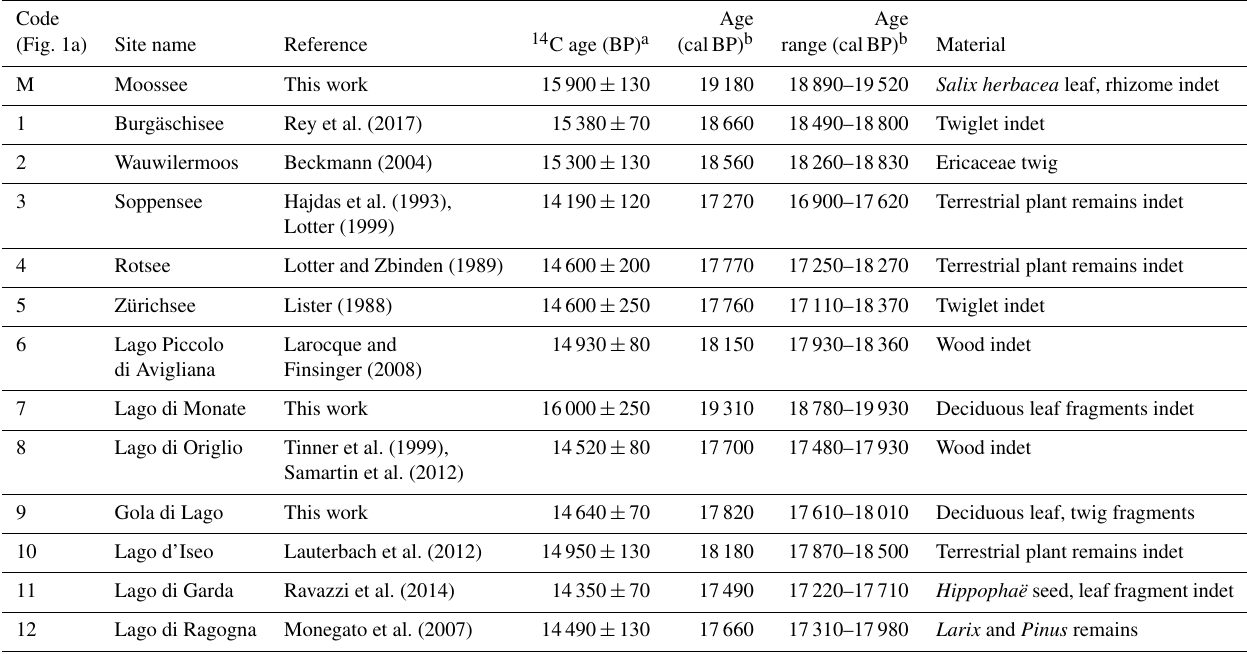
Table 2. Oldest radiocarbon dates from terrestrial plant remains found in sediment sequences from lakes north and south of the Alps. Uncertainties in 14 C ages refer to 68% probabilities (1 σ ), whereas ranges of calibrated ages represent 95% probabilities (2 σ